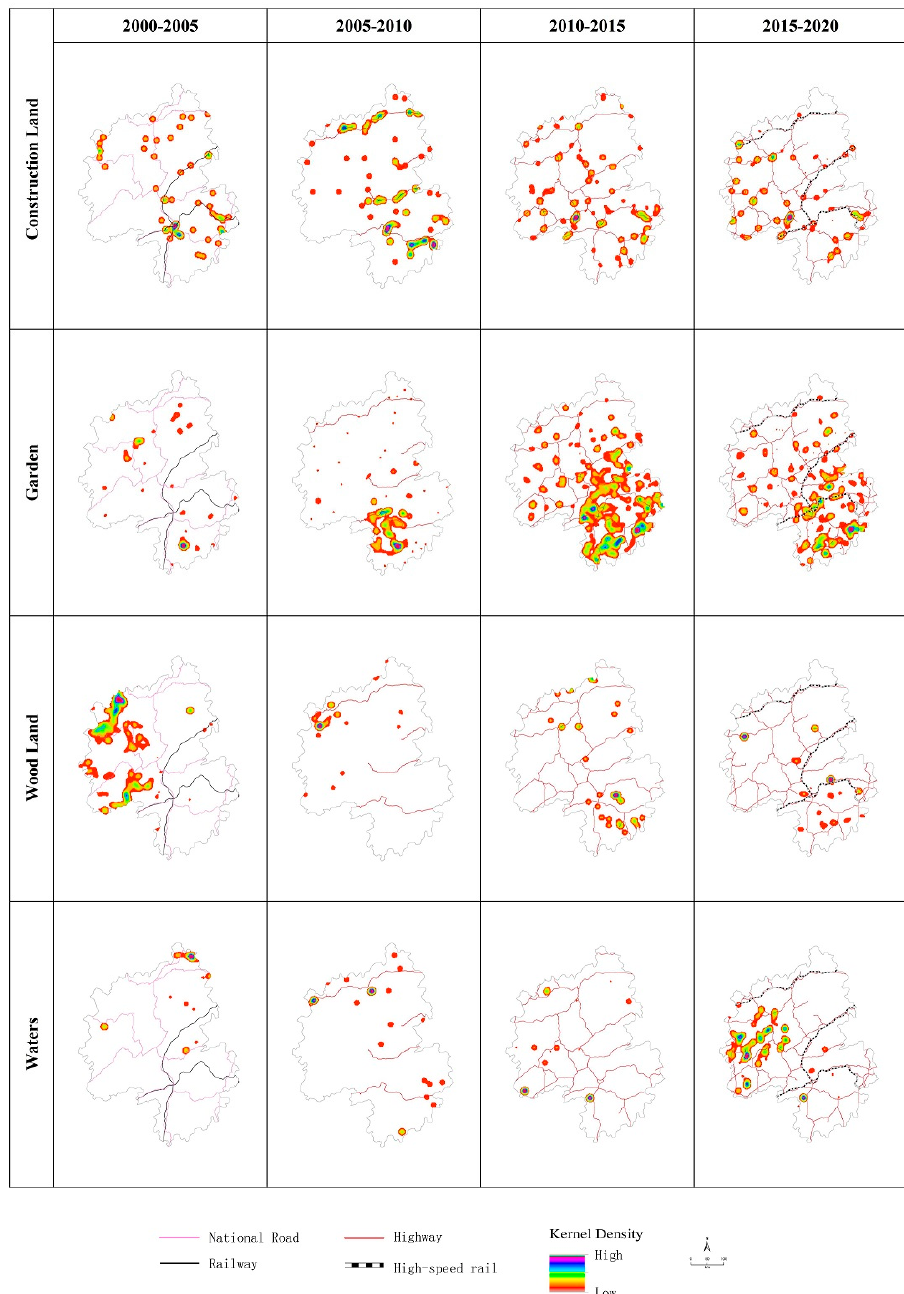
Figure 6. Kernel density analysis of the spatial changes in major land